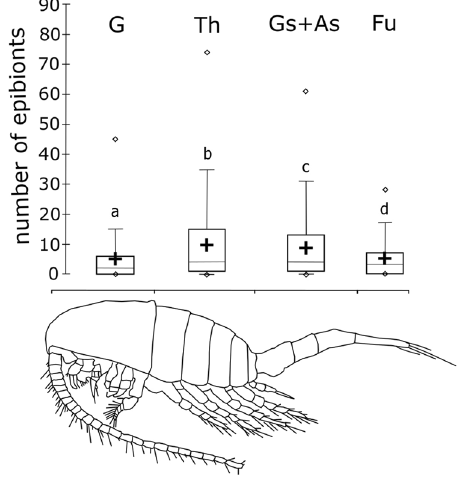
Figure 5. Boxplot of epibiont number among the body parts of Eurytemora lacustris showing preferences of Tokophrya to certain body parts. Different letters (a-d) indicate significant differences in infection level with p value < 0.005 for Th and Gs + As, and p value < 0.001 between other parts of the body. G—cephalosome; Th— pedigerous somite; Gs + As—genital somite and anal somite; and Fu—caudal ramus.